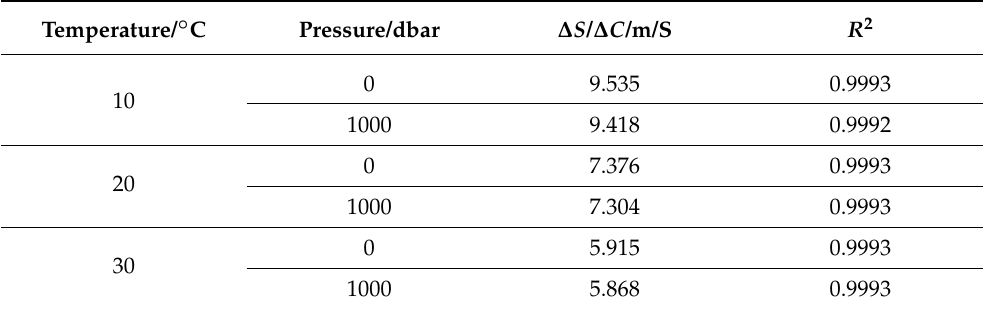
Figure 1. The relation of salinity and conductivity, temperature and pressure. ( a ) Pressure slice planes. ( b ) Conductivity slice planes. ( c ) Temperature slice planes. ( d ) The salinity versus conductivity under different temperature and pressure. ( e ) The salinity versus temperature under different conductivity and pressure. ( f ) The salinity versus pressure under different conductivity and temperature. Table 1. The ratio of change of salinity ∆ S to change of conductivity ∆ C at different temperature- pressure